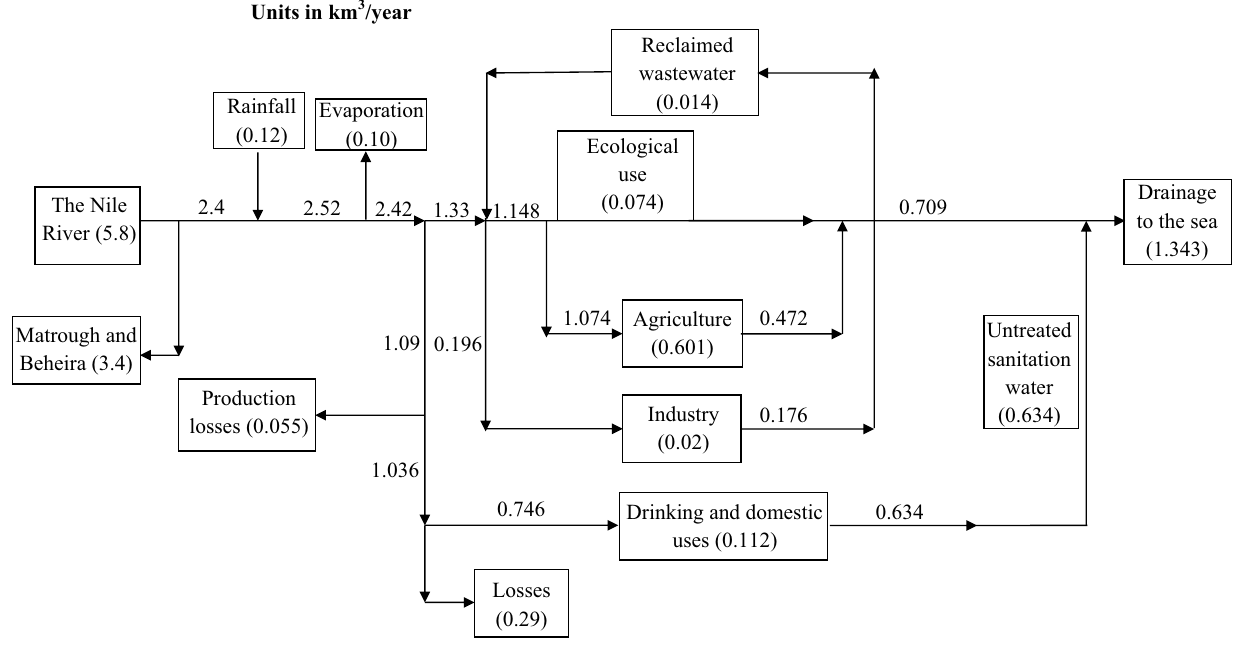
Fig. 5 Available water resources for Alexandria Governorate and their